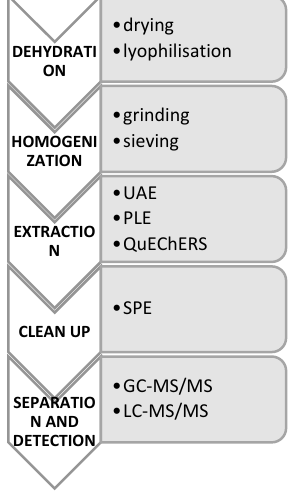
Figure 2. Stages of the analysis of the content of micropollutants in sewage sludge with examples of methods [11,19,20,22]. Abbreviations: UAE—ultrasound-assisted extraction; PLE—pressurised liquid extraction; QuEChERS—quick, easy, cheap, effective, robust, and safe; SPE—solid-phase extraction; GC—gas chromatography; LC—liquid chromatography; MS/MS—tandem mass